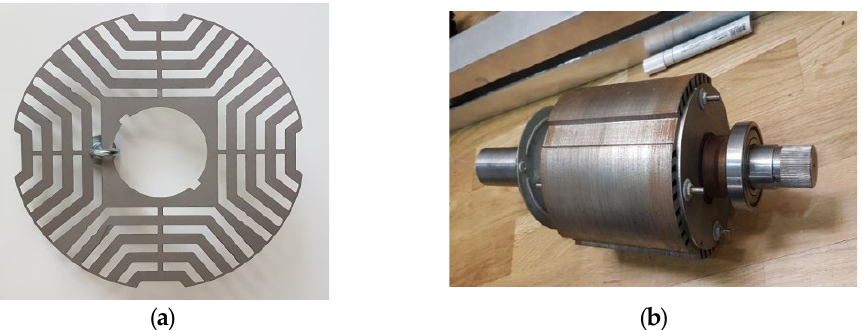
Figure 7. Cross-section of the rotor with transversally laminated anisotropy: ( a ) rotor sheet ( b ) exper- imental rotor model.